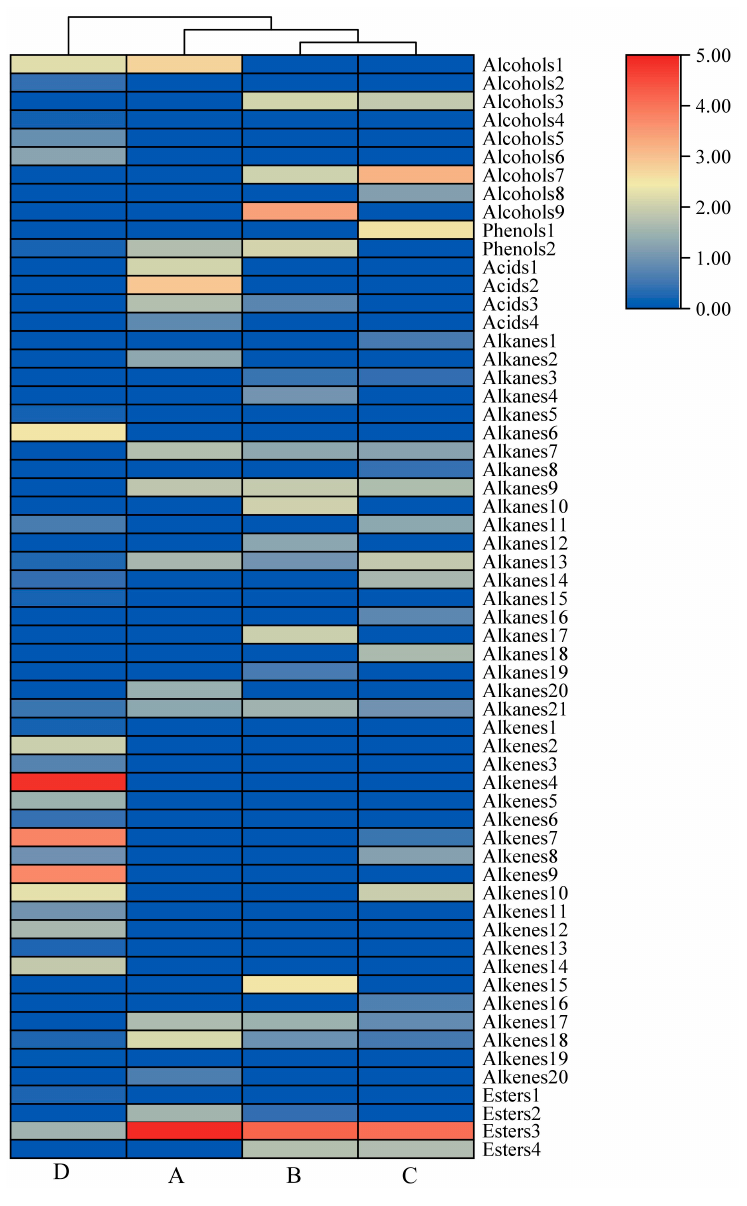
Figure 4. Hierarchical cluster analysis (HCA) of the four cabya fruit color stages based on content of 60 VOCs.